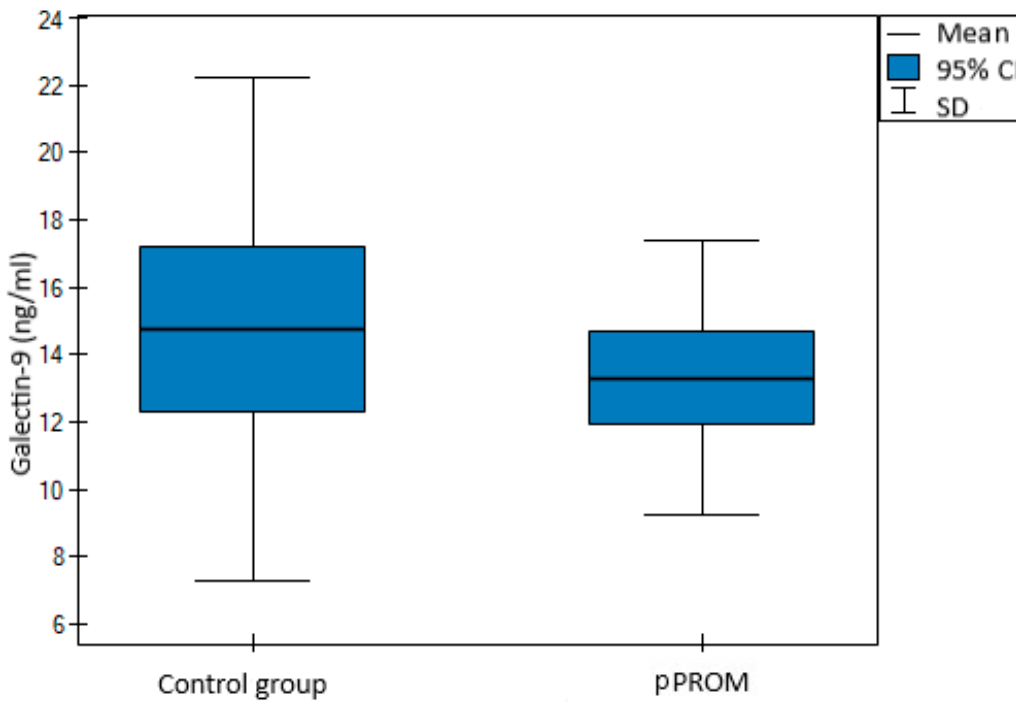
Figure 2. Distribution for maternal serum galectin-9 levels in study vs. control group.